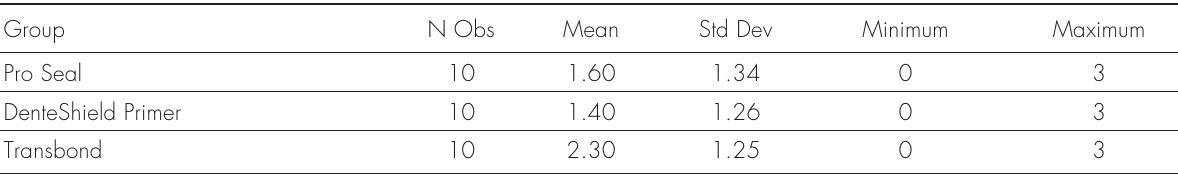
Table II. Adhesive remnant ratio.